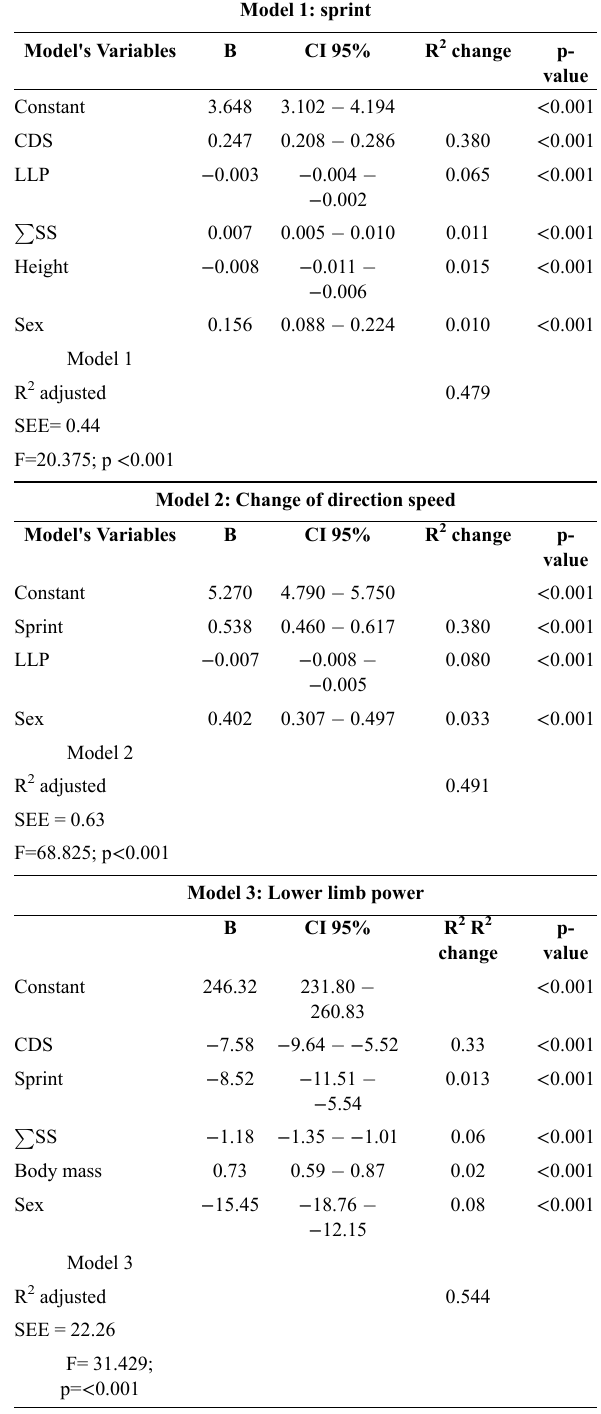
Table 2 - Correlation between variables lower limb power, change of Table 3 - Multiple linear regression models to estimate the associations direction speed, and sprint from adolescents aged 10-17. between sprint, lower limb power, change of direction speed and adjust- ment variables All sample